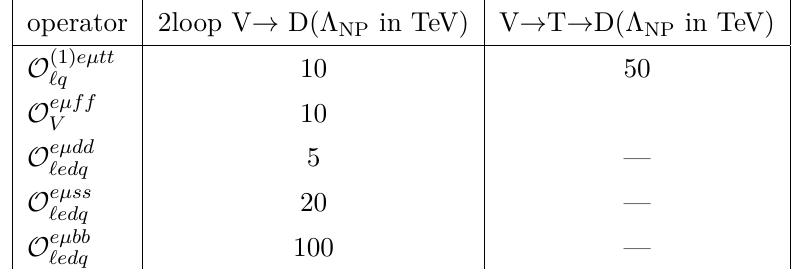
Table 7 . Operators which contribute to µ → eγ via two-loop mixing in the RGEs, and in the second column, our powercounting estimate for the scale Λ probed. The third column gives the estimated sensitivity obtainable via the one-loop RGEs. O eµff schematically refers to all the dimension six vector four-fermion operators with f 6 = t .